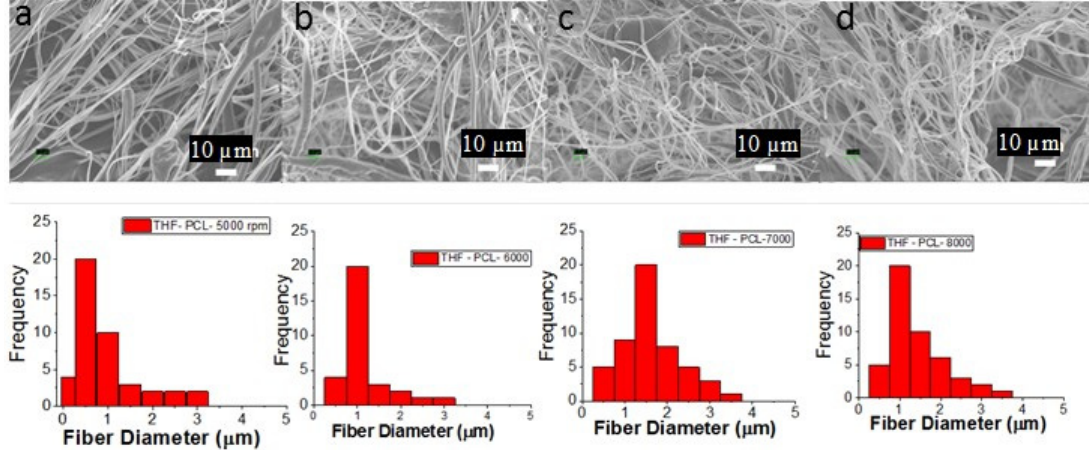
Figure 5. SEM images of PCL fibers prepared from 12.5 wt% PCL in THF as the solvent at different rotational speeds. ( a ) 5000 rpm; ( b ) 6000 rpm; ( c ) 7000 rpm; ( d ) 8000 rpm and corresponding histograms of the fiber diameter.